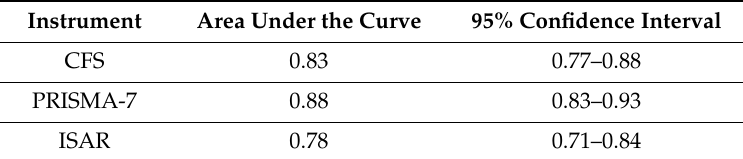
0.59 – 0.77 Figure 2. Receiver operating characteristic curves with area under the curve scores showing the accuracy of the Clinical Frailty Scale (CFS), Programme of Research to Integrate Services for the